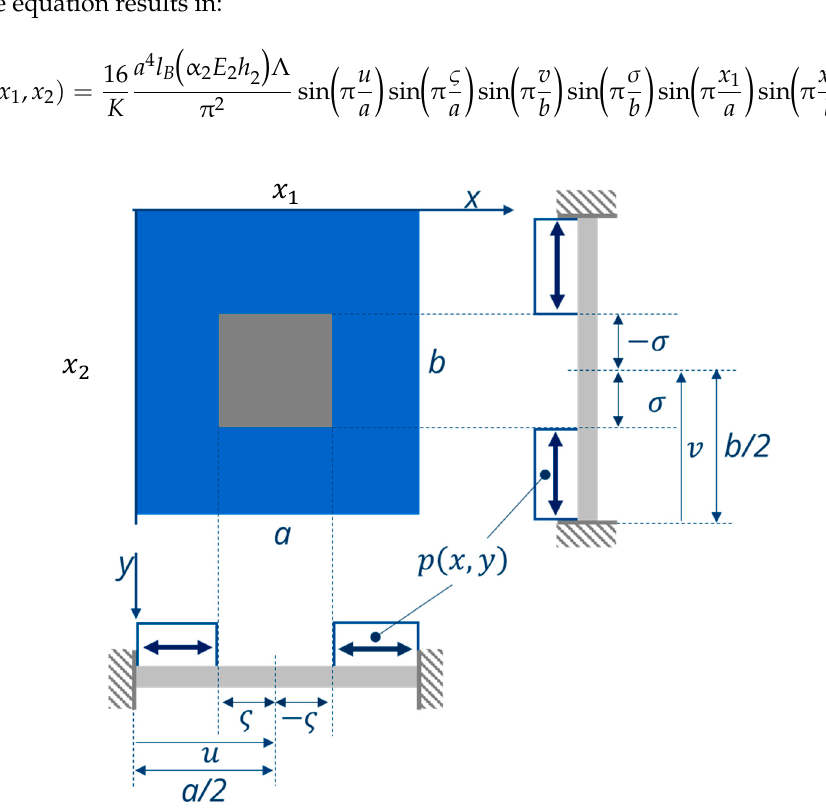
Figure 7. All-side-clamped rectangular bending plate (grey) with edge lengths a and b , with the outer side covered with a swellable layer.